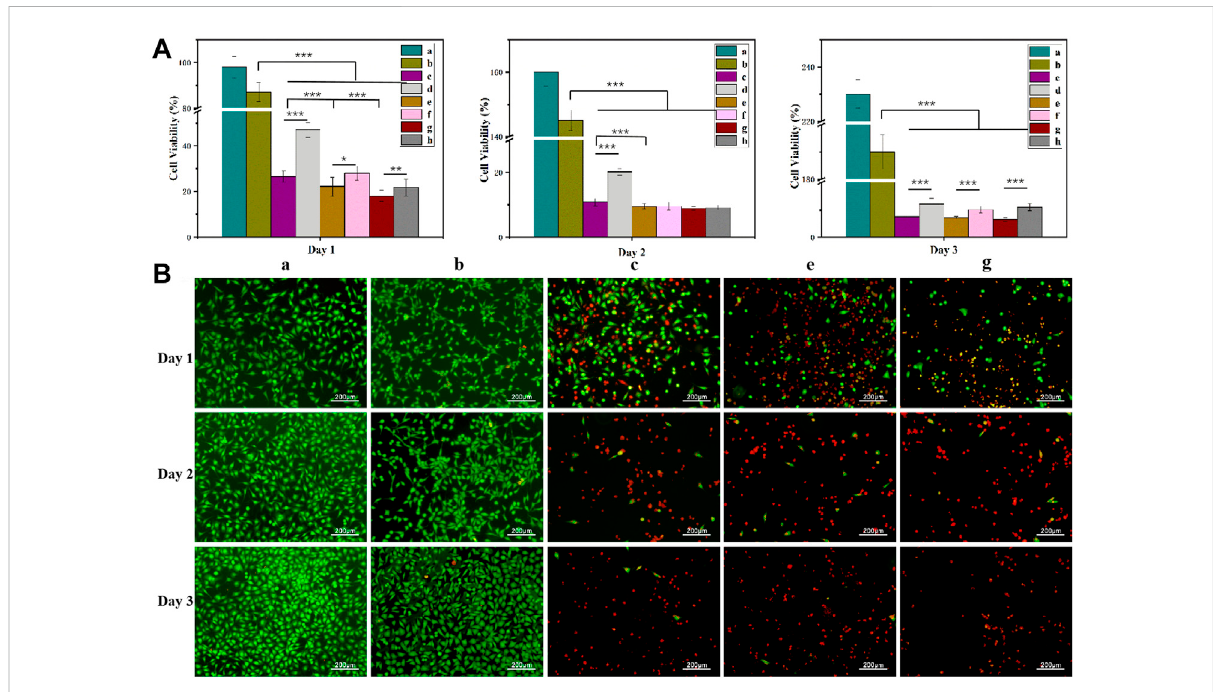
FIGURE 8 MCF-7 cell viability measured using the CCK-8 assay (A) and AO/EB staining results (B) . a: Blank; b: CSSH gels; c: Cur – Lip/Dox/CSSH gels (100 μ M/50 μ M Cur/Dox); d: Dox/CSSH gels (50 μ M); e: Cur – Lip/Dox/CSSH gels (100 μ M/75 μ M Cur/Dox); f: Dox/CSSH gels (75 μ M); g: Cur –